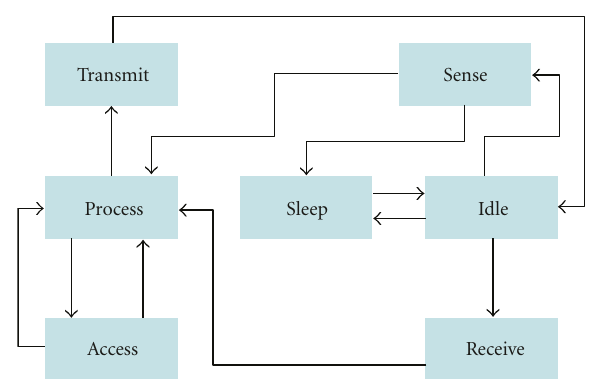
Figure 4: Model of working state